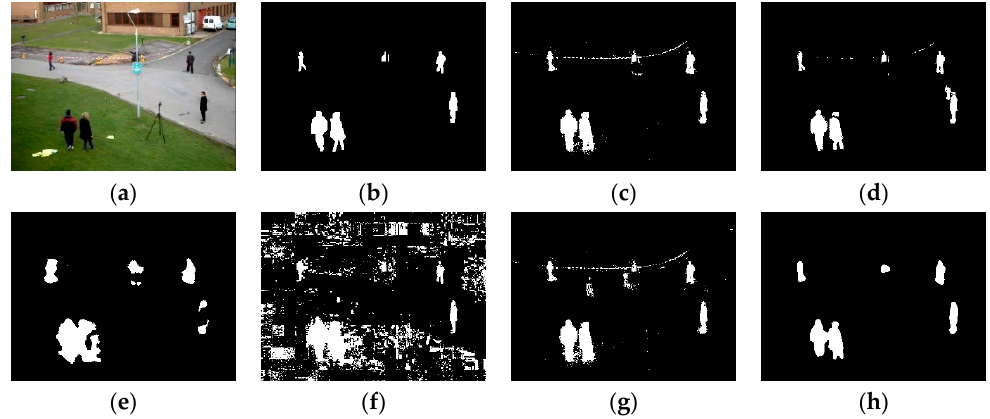
Figure 5. ( a ) Frame 555 of input images; ( b ) the ground truth; ( c ) GMM (Gaussian Mixture Modeling); ( d ) ViBe (Visual Background extractor); ( e ) GMG (an algorithm for finding the Global Minimum with a Guarantee); ( f ) KDE (Kernel Density Estimation); ( g ) LBAdaptiveSOM (Local Background Adaptive Self-Organizing Modeling); and ( h ) our method.